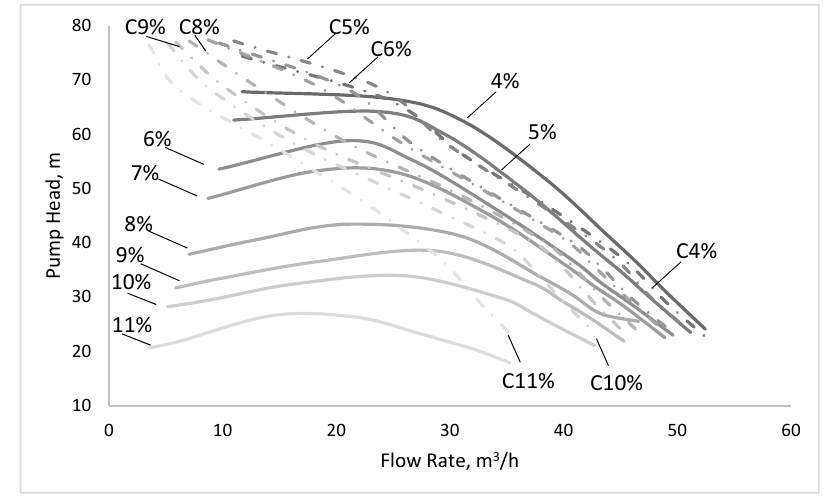
Figure 8. Comparison between experimental pump characteristic curves and those obtained through the correction method.